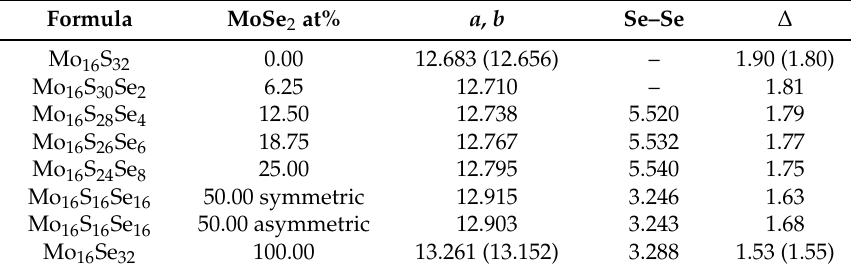
Table 3. Calculated lattice parameters a and b (Å) of the 4 ˆ 4 supercell, dopant closest distances (Å) and the band gaps, ∆ (eV), of the most stable MoSe 1 ´ x S x systems with Se atoms included in both chalcogen layers. Experimental data are given in parenthesis [1,39–42].